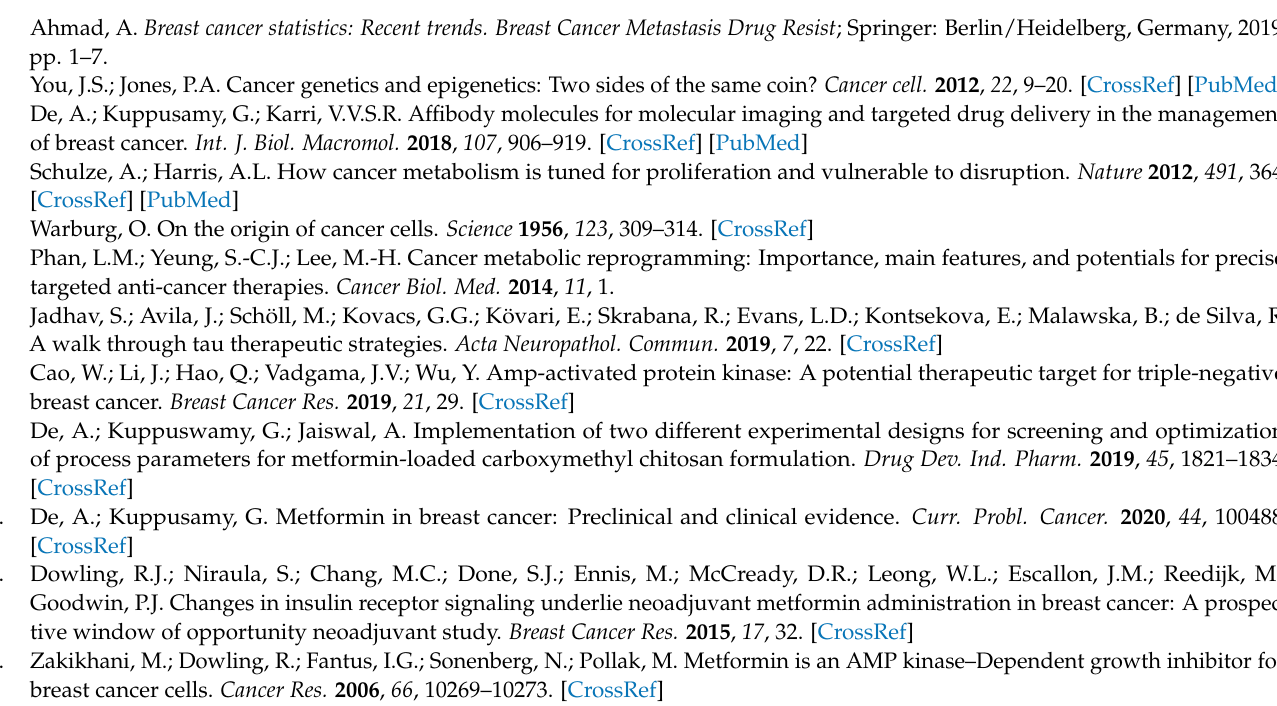
Figure S2: Particle size and zeta potential of OCMC-MET Nps. Table S1: % Swelling of OCMC-MET at different pH and time